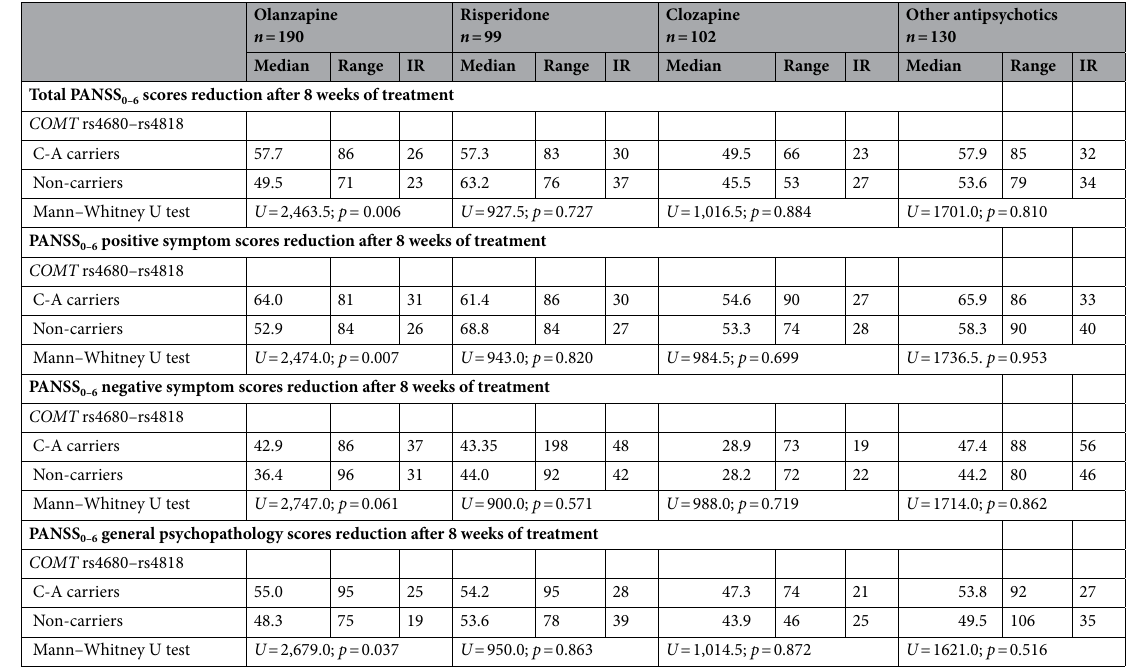
therapeutic response to olanzapine 20, 21 . Two studies with small sample sizes, evaluating olanzapine monotherapy,